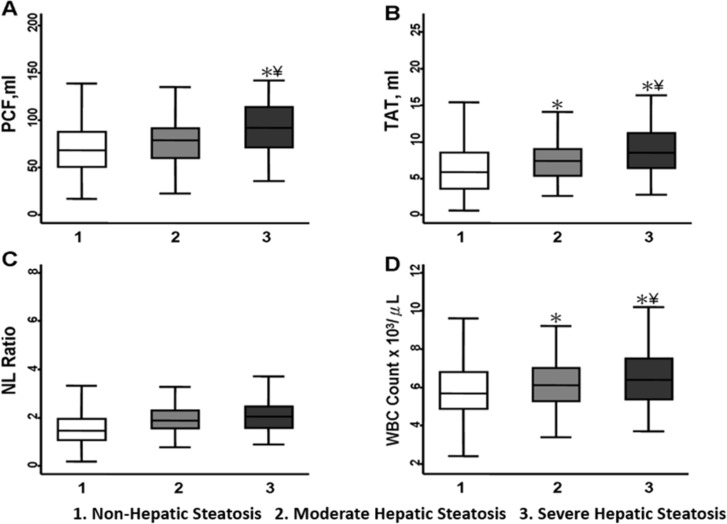
PCF, TAT, NLR, total leukocyte counts across hepatic steatosis category.Higher severity of Hepatic Steatosis [categorized as (1) No/Mild, (2) Moderate, and (3) Severe] was associated with greater burden of visceral adiposity (A and B) and higher total leukocyte counts (D), but was not associated with NLR (C). *p<0.05 compared to Non- Hepatic Steatosis group, ¥p<0.05 compared to Moderate Hepatic Steatosis group.